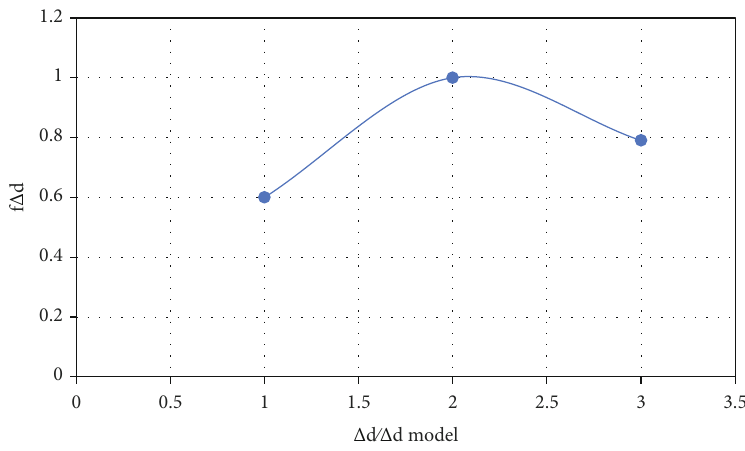
Figure 3: Drop of isentropic enthalpy.